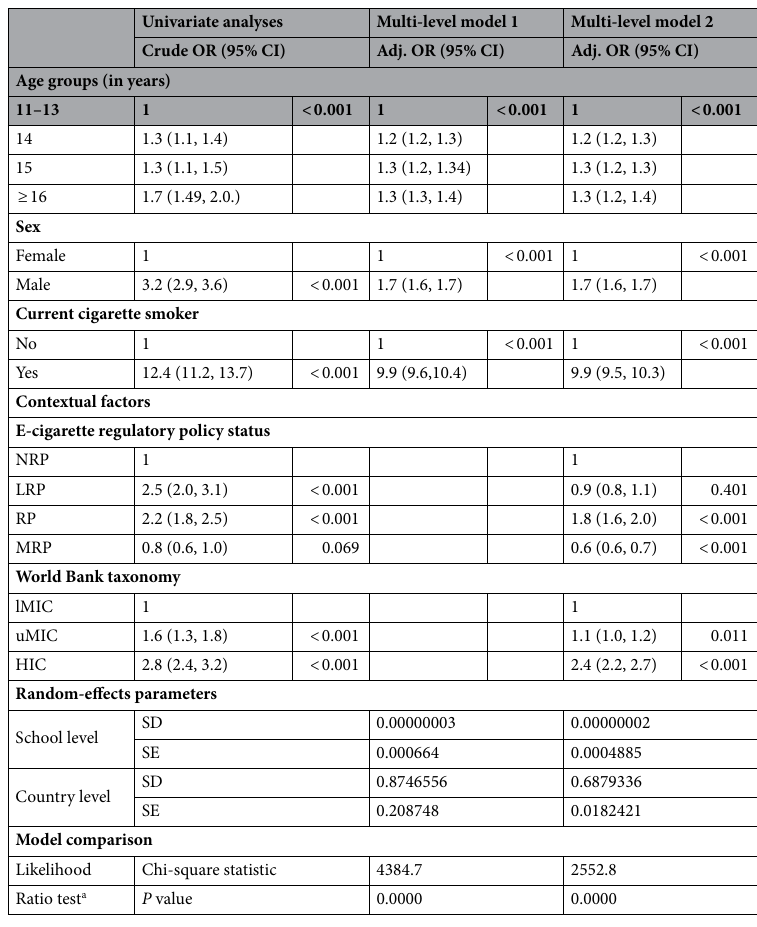
Table 3. Socio-demographic and contextual factors associated with current e-cigarette use among youth by multi-level regression analyses. a Based on the results on likelihood ratio tests, estimates of multilevel